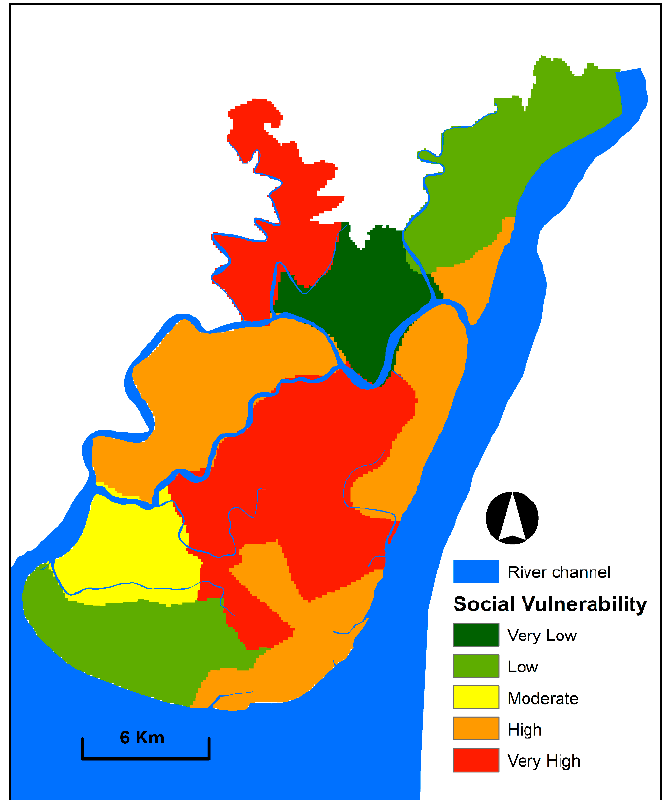
Figure 7. Social vulnerability map exhibiting spatial patterns and the degree of social vulnerability to floods.